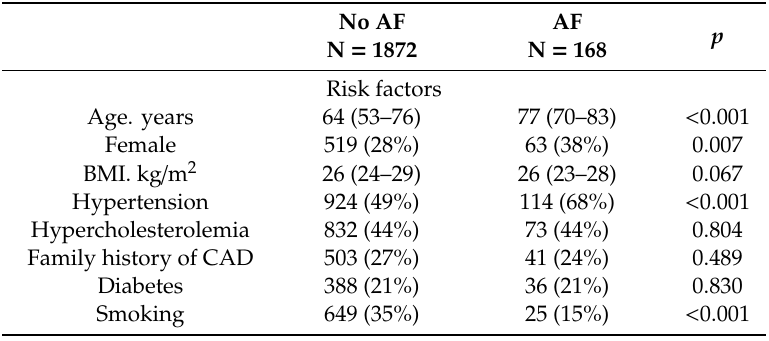
Table 1. Patient Baseline Characteristics (n (%) or median (interquartile